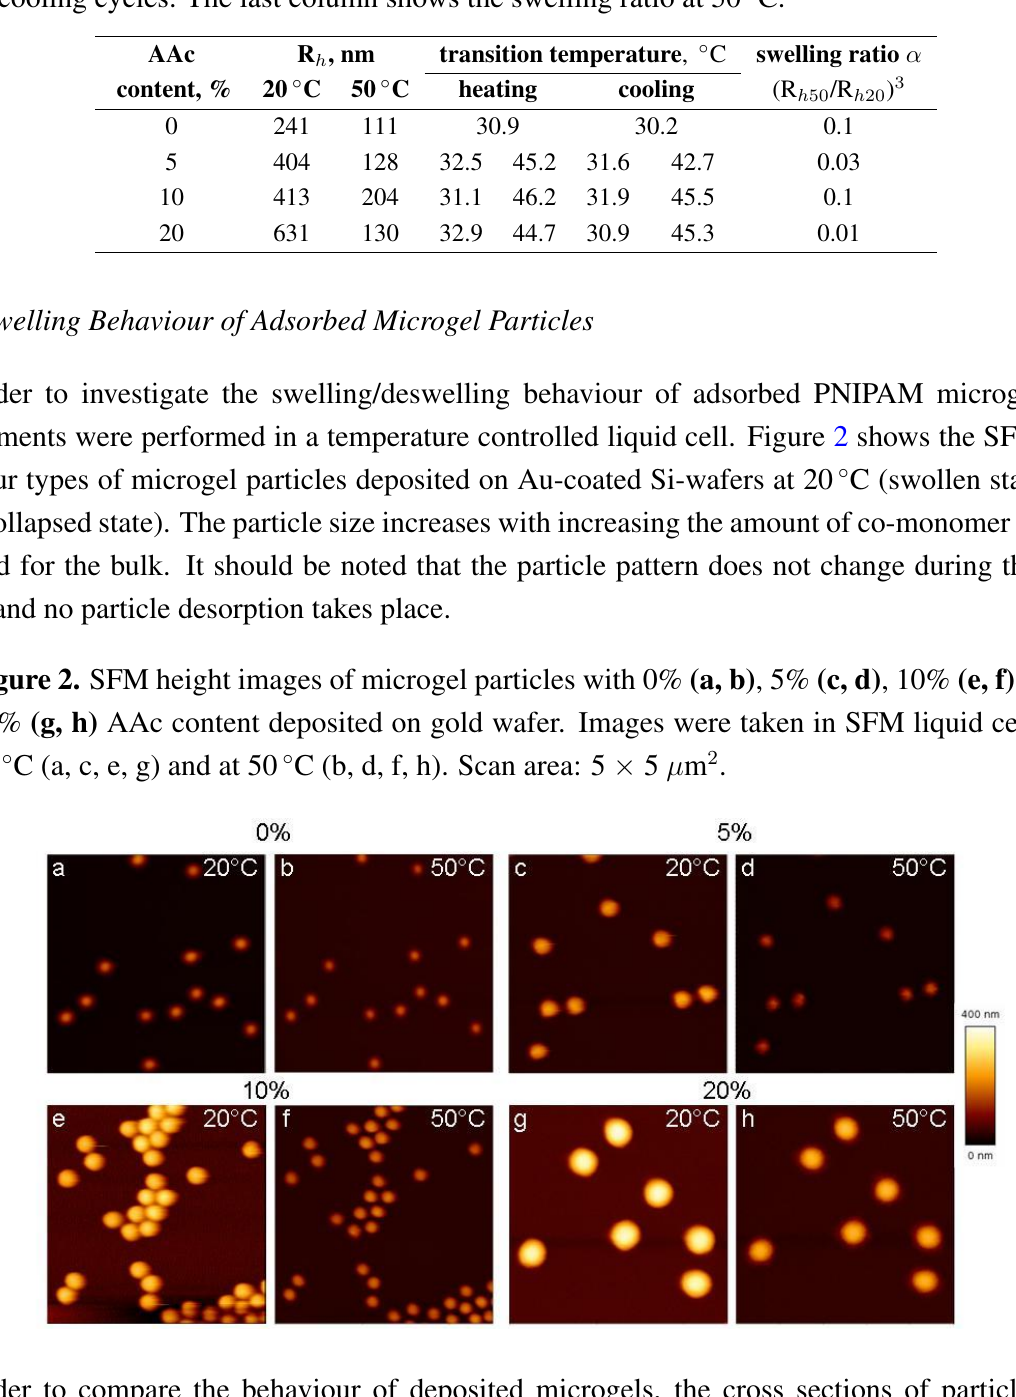
Table 2. Characteristics of microgel particles with 0%, 5%, 10% and 20% AAc in bulk: hydrodynamic radius (R ) at 20 ◦ C and at 50 ◦ C and transition temperatures in heating and h in cooling cycles. The last column shows the swelling ratio at 50 ◦ C.